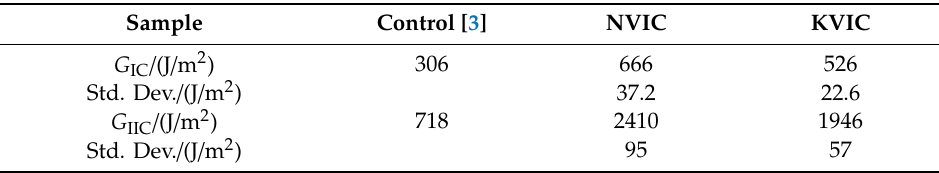
Table 3. The interlaminar toughness of three interleaved composites.